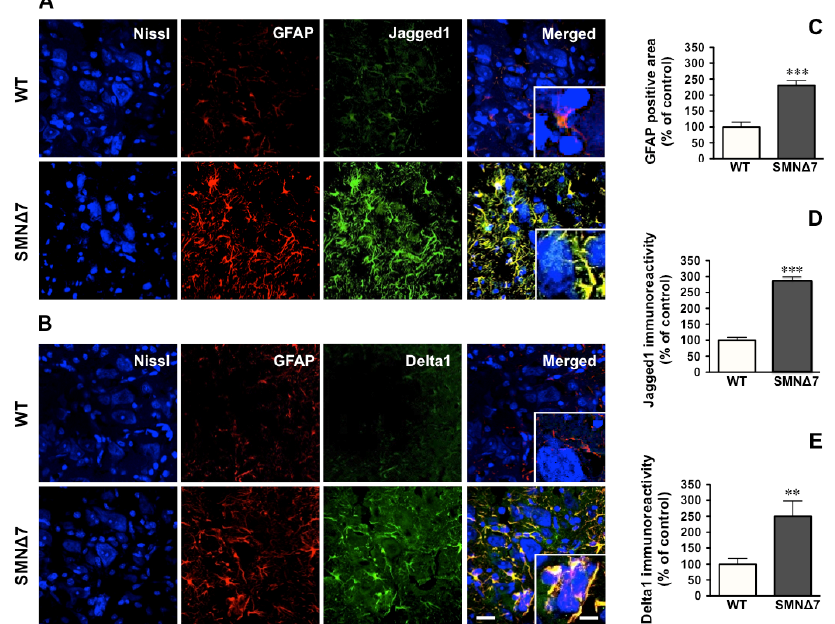
Figure 2. Astrocytosis and increased expression of Jagged1 and Delta1 in the ventral spinal cord of SMN Δ 7 mice. ( A , B ) Representative images of anti-glial fibrillary acidic protein (GFAP) and Jagged1 ( A ) or GFAP and Delta1 ( B ) immunohistochemistry in the ventral horn of lumbar spinal cord of P11 wild-type (WT) and SMN Δ 7 mice. Insets: astrocytes processes double labeled with GFAP and Jagged1 in ( A ) or with GFAP and Delta1 in ( B ) are in close apposition with motoneurons labeled with blue fluorescent Neuro Trace Nissl staining. Scale bars in ( B ) = 20 μ m and 10 μ m (inset), also apply to ( A ). ( C ) Columns represent the percentage of GFAP positive area in the ventral horn of lumbar spinal cord of P11 SMN Δ 7 as compared to control (WT) mice and represent the mean ± SEM (error bars) of at least four mice for each group. *** p < 0.001 as compared to age-matched WT. ( D , E) Columns represent the percentage of Jagged1 ( D ) or Delta1 ( E ) immunoreactivities in GFAP-positive cells (astrocytes) in the lumbar spinal cord of P11 SMN Δ 7 as compared to control (WT) mice and represent the mean ± SEM (error bars) of at least four mice for each group. *** p < 0.001 and ** p < 0.01 as compared to age-matched